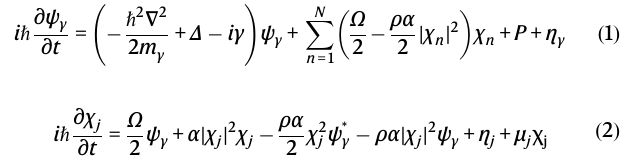
Fig. 3 | Polariton nonlinear interaction in the superlattice-N3. a Scheme of the pump-probeexperimentinwhichthepumpinjectspolaritonsintothegroundstate and the probe (broad in energy) monitors the UPB and LPB dispersion at high momenta. b Angle-resolved re fl ectivity maps for low and high pumping power, respectively. The left (right) part of the fi gures shows the calculations (experi- ments). Power sweep of the LPB ( c ) and UPB ( d ) re fl ectivity energy pro fi les